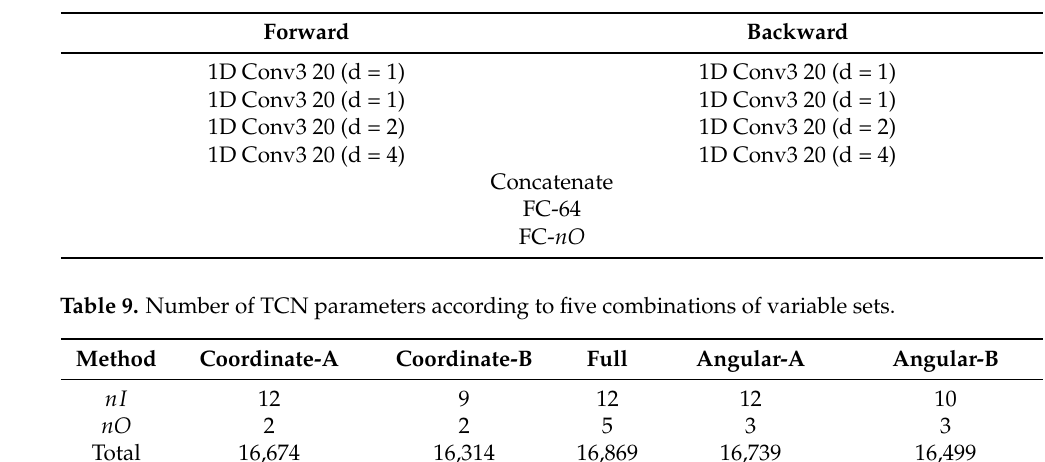
Table 8. Network parameters for proposed TCN-based DDP model.